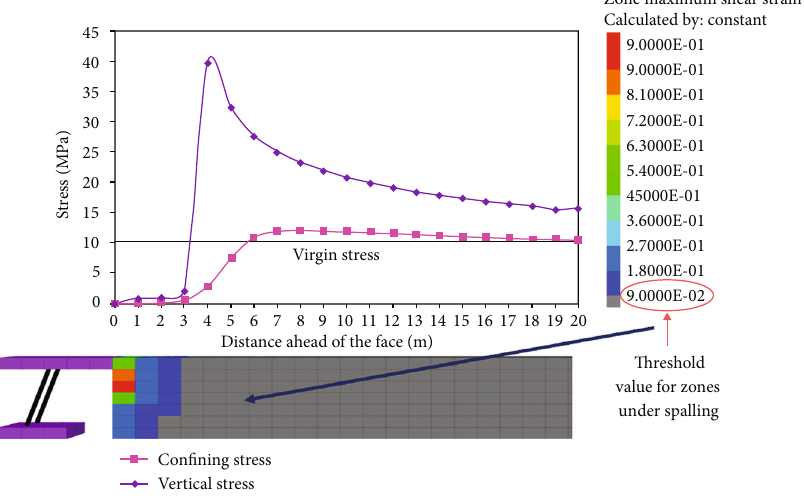
Figure 9: Spalling estimation of coal wall for ALP panel 1